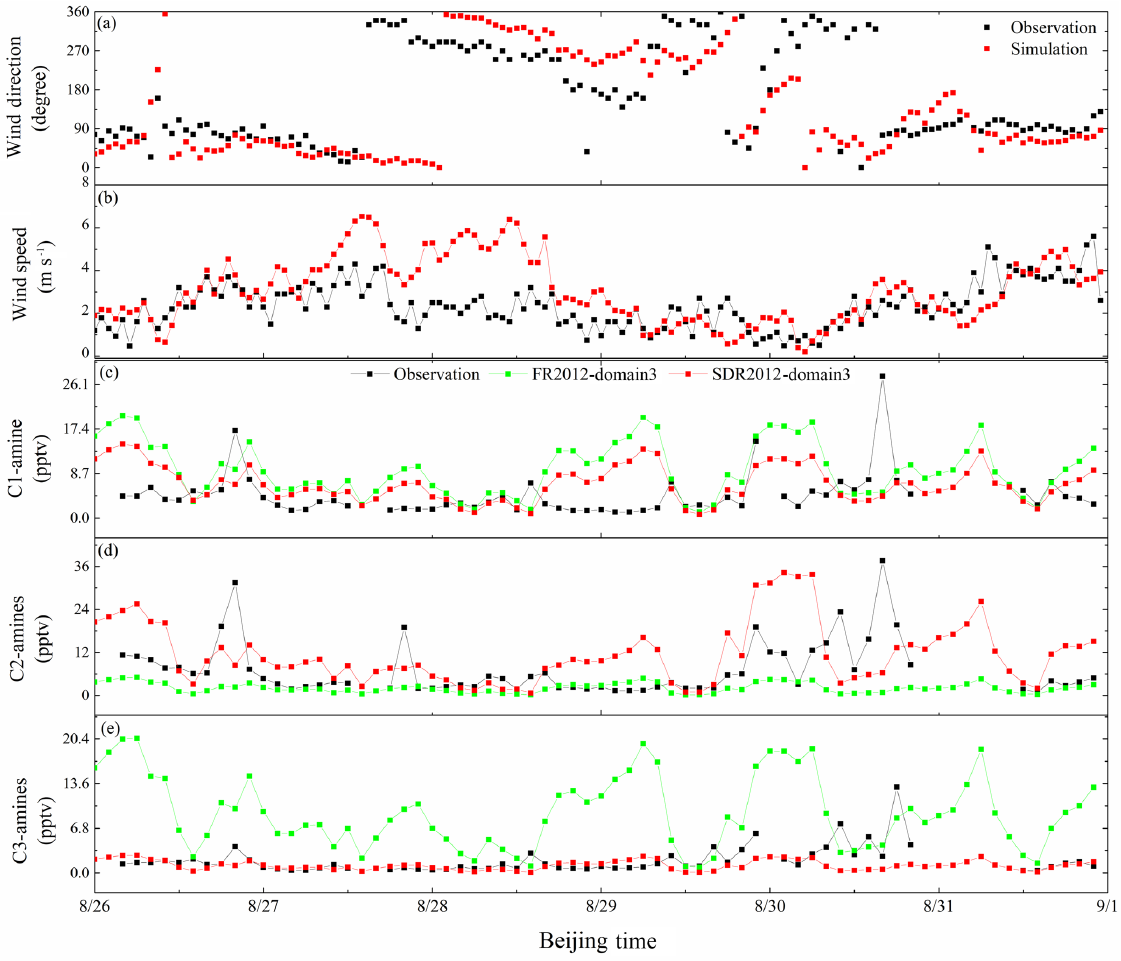
Figure 5. Comparisons of simulated and observed wind direction at 10m (a) , wind speed at 10m (b) , C1-amine (c) , C2-amines (d) , and C3-amines (e) concentrations at the NUIST site in Nanjing, China, from 26 to 31 August 2012. In ( c–e ), black, red, and green lines represent observations, simulated values in domain 3 based on SDR, and simulated values in domain 3 based on FR,